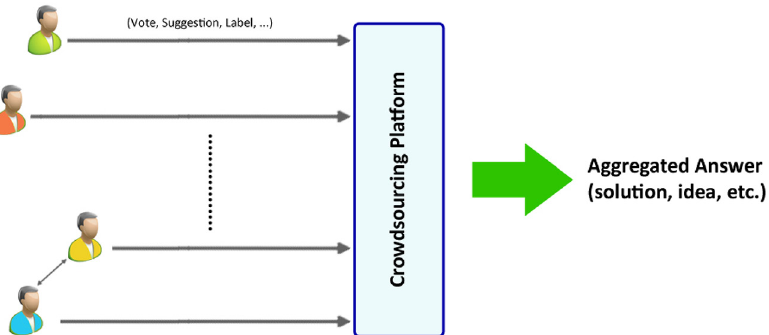
Figure 1. Simpli fi ed schematic of CHI work fl